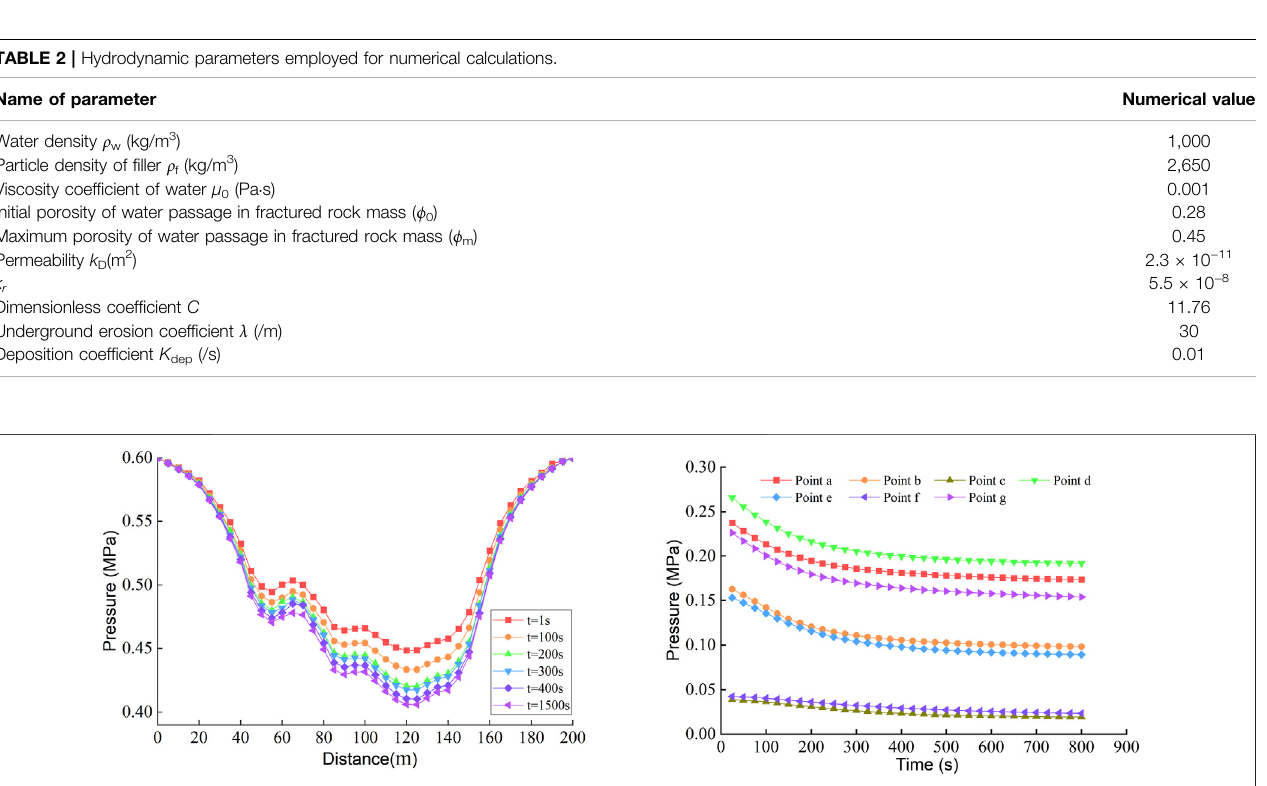
FIGURE 11 | Pressure evolution at the measuring line and typical